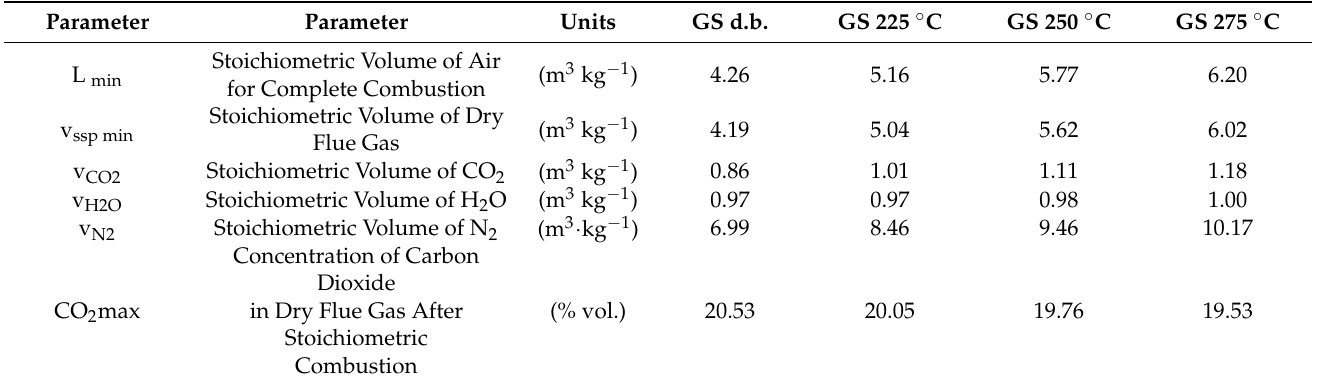
Table 5. Stoichiometric amount of air and specific productions of flue gas components from combustion grape pomace from grape stalk (GS); d.b., dry basis.